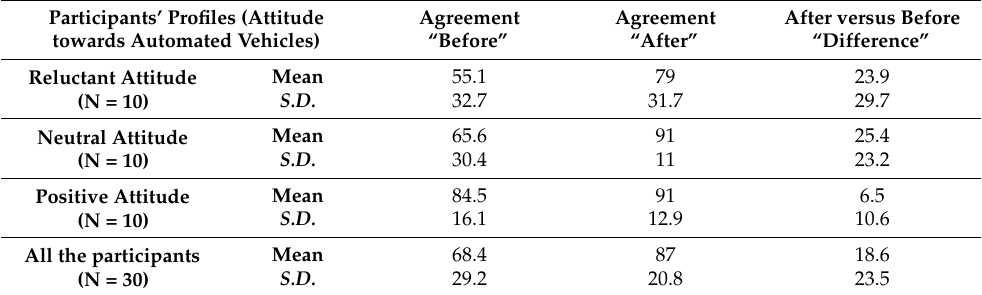
Table 3. Effect of HCAI-based automation experience on drivers’ acceptance of automated vehicle. Participants’ Profiles (Attitude towards Automated